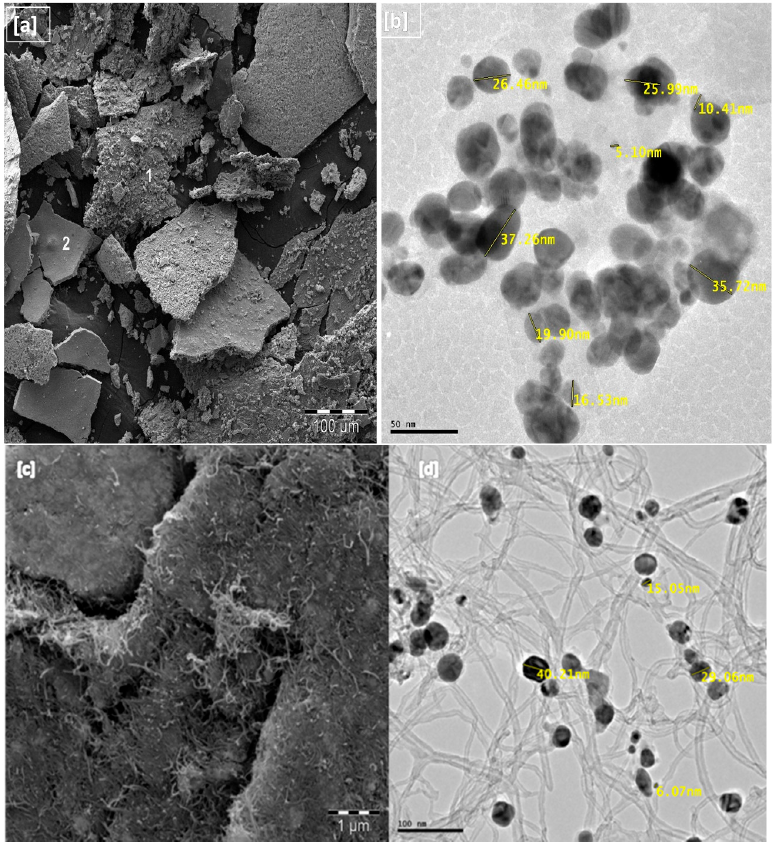
Figure 3. ( a ) SEM and ( b ) TEM images of the as-synthesized Costus afer mediated silver nanoparticles ( c ) SEM and ( d ) TEM images of the